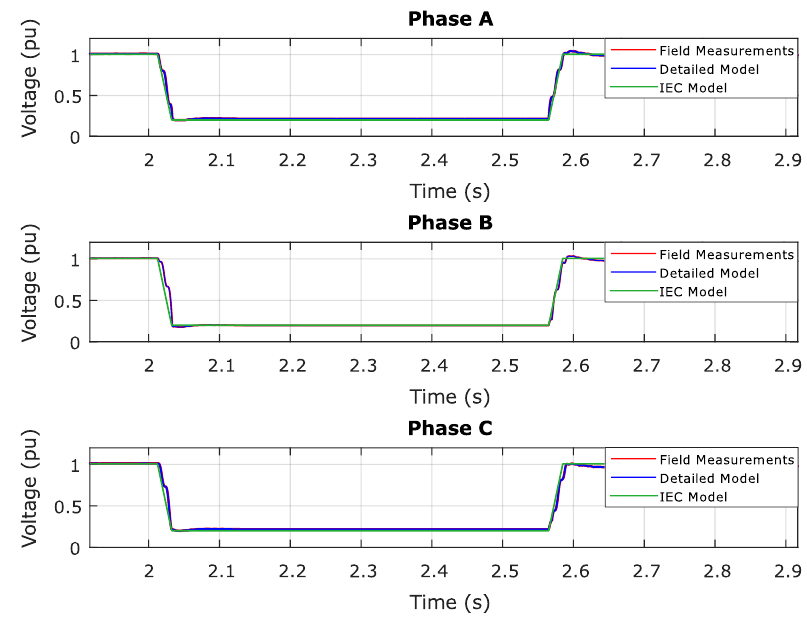
Figure 2. RMS voltage in each phase: measured and simulated.